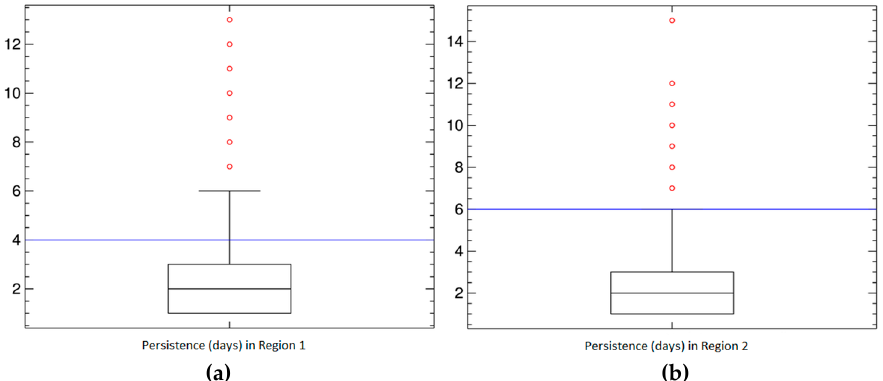
(b) Figure 3. Box plot of the distribution of the daily maximum temperature (Tmax) anomalies (°C) in regions ( a ) 1 and ( b ) 2. The horizontal blue line represents the 90% percentile of these anomalies and the red circles represent the extreme values. Some indices that define heat wavesthrough the P90 threshold of temperaturealready exist in the literature, such as the Warm Spell Duration Index (WSDI) [11].However an arbitrary value of persistence is still used.In this study, the persistence of the events was defined as the number of consecutive days whenTmax anomalies remained above P90 (Figure 4). Persistence varied from 1 to